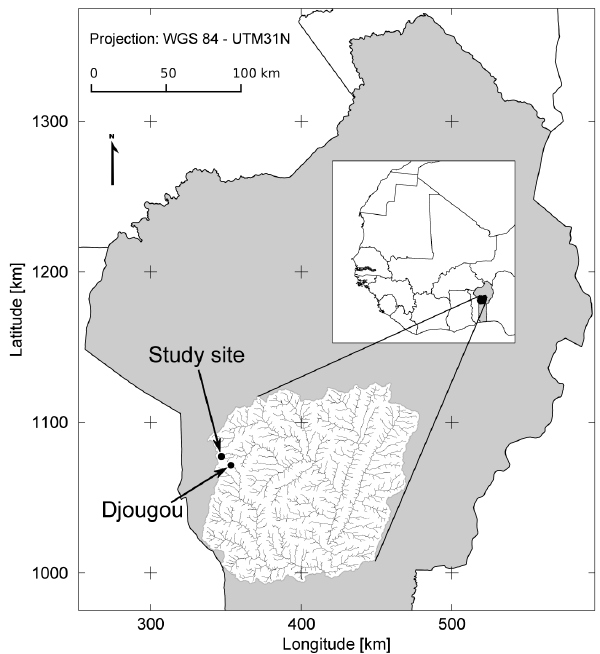
Fig. 1. Location of the study site. The watershed is the Sudanian climate mesoscale site of the AMMA-CATCH observing system, northern Benin, West Africa. Republic of Benin is the grey area.